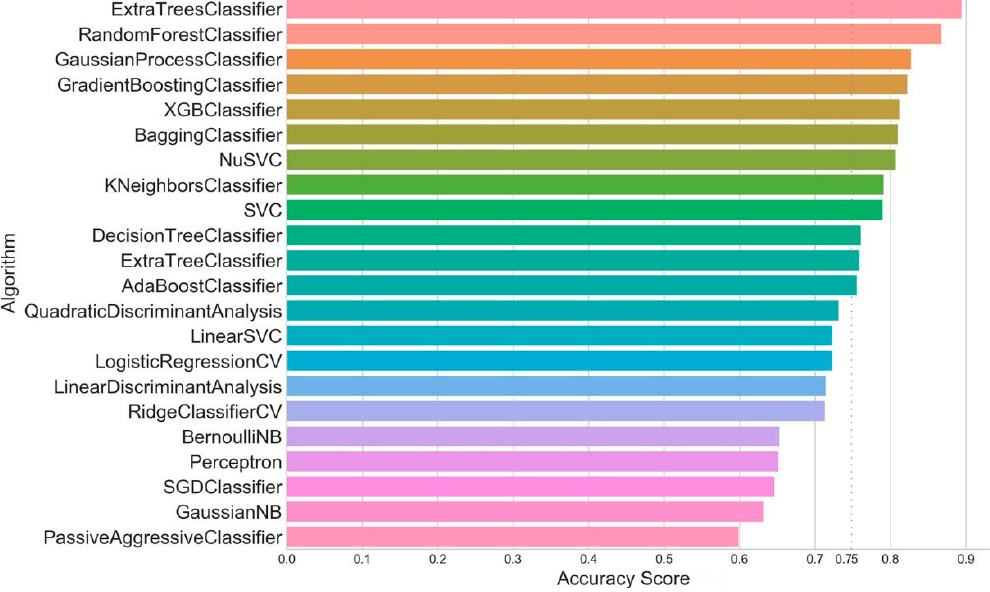
Figure 8. Ranking of model accuracy scores. Table 3. Confusion matrix.